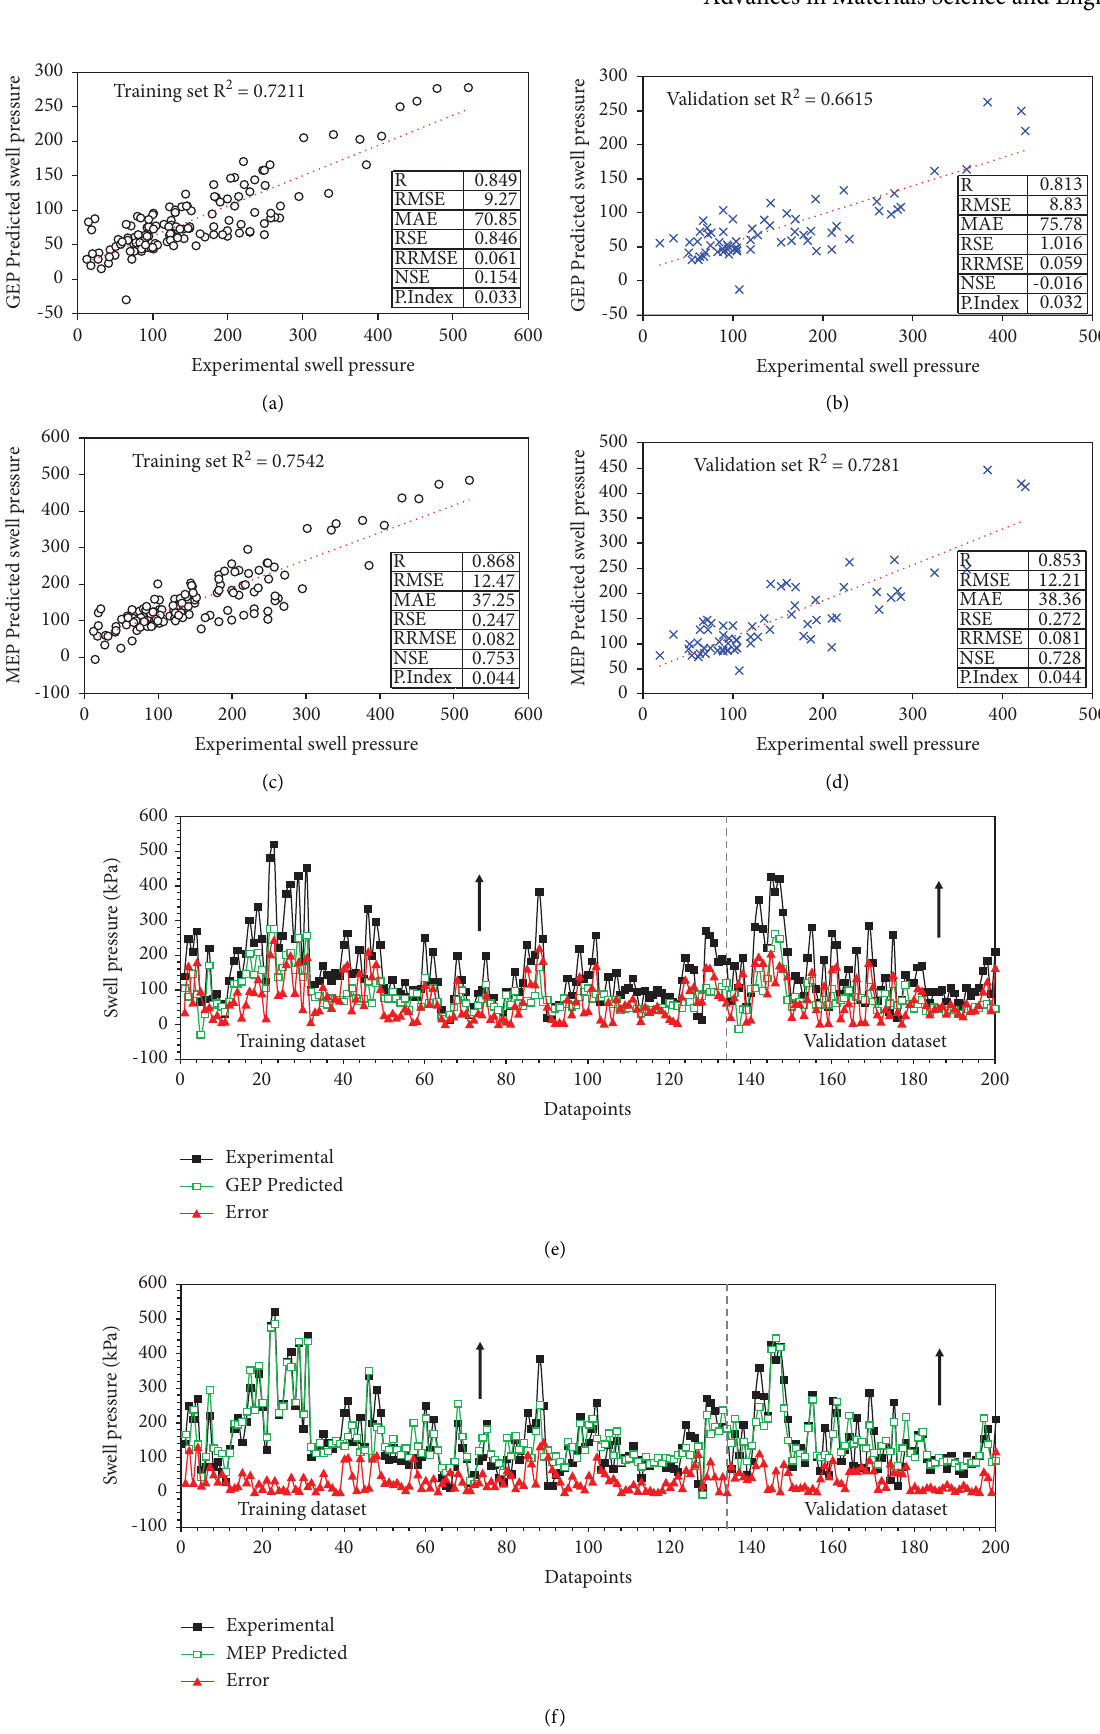
Figure 7: Experimental versus predicted swelling pressure using genetic programming-based approaches with performance